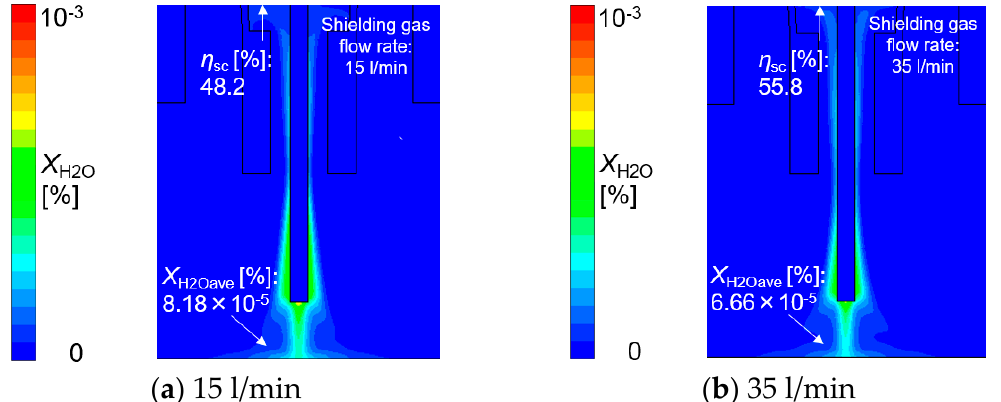
Figure 8. The effect of the shielding gas flow rate on the mole fraction of H 2 O: ( a ) 15 l/min, ( b ) 35 Figure 8. The e ff ect of the shielding gas flow rate on the mole fraction of H 2 O: ( a ) 15 l / min, ( b ) 35 l / l/min.